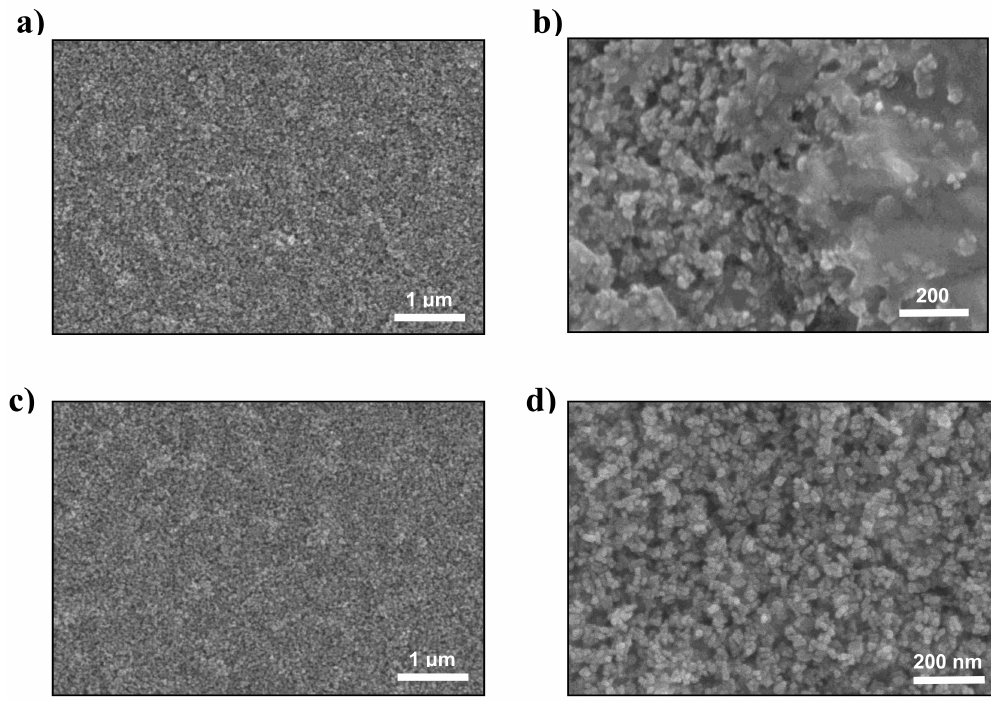
Figure 4. Scanning electron microscopy images of mesoporous TiO 2 sintered at low temperatures ( a , b ) without and ( c , d ) with the surface modification process, at ( a , c ) 20,000 × and ( b , d ) 100,000 ×